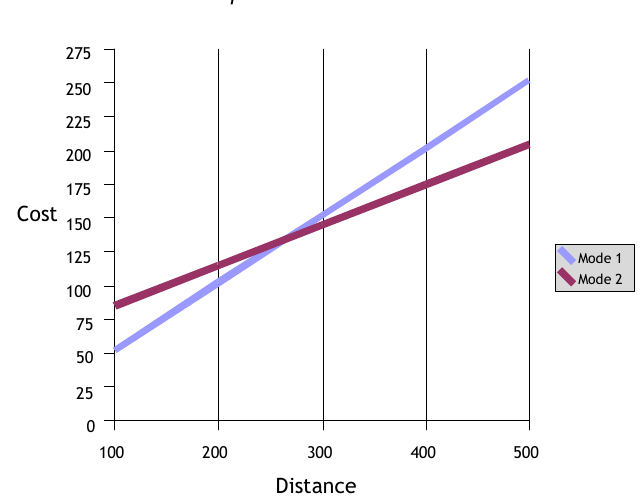
Figure 4. Original cost